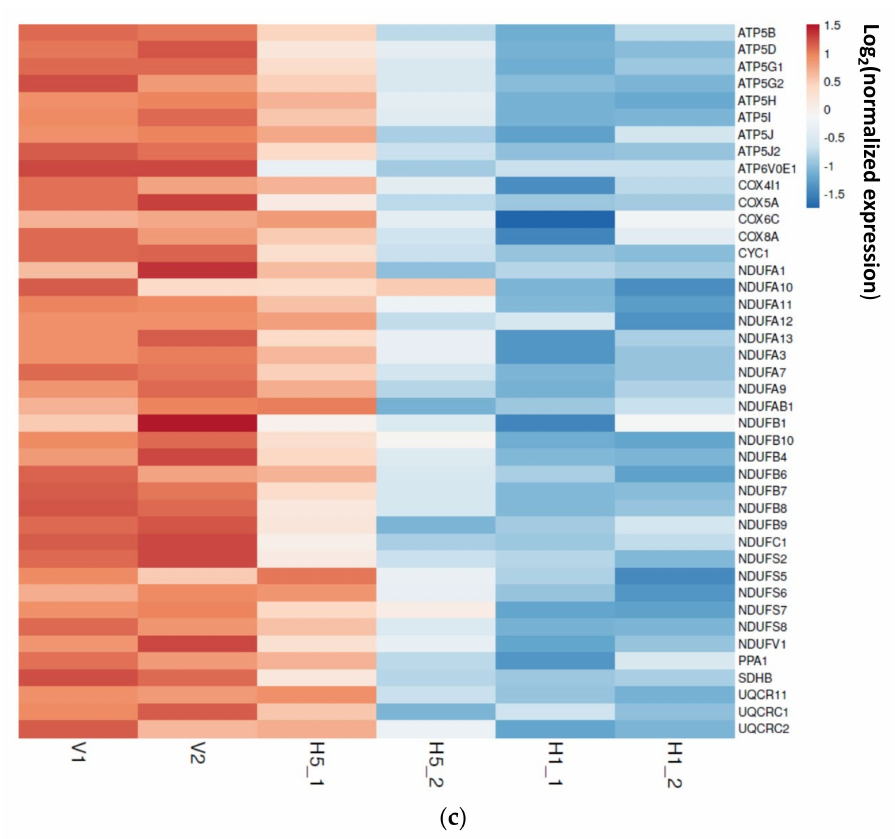
Figure 6. 8-OHD-downregulated genes involved in oxidative phosphorylation. ( a ) The top 15 KEGG pathways associated with genes commonly downregulated by both 50 and 100 µ M 8-OHD were analyzed with DAVID functional annotation cluster tool. Oxidative phosphorylation was the second most significantly enriched pathway. ( b ) KEGG “Oxidative Phosphorylation” pathway (hsa00190) associated with 8-OHD-downregulated genes. E: eukaryote; B: bacteria; A: archaea. Downregulated genes obtained from the microarray are marked in red. ( c ) Heatmap of expression patterns of some oxidative phosphorylation-associated genes in response to 8-OHD. H5 and H1 represent 50 and 100 µ M 8-OHD,